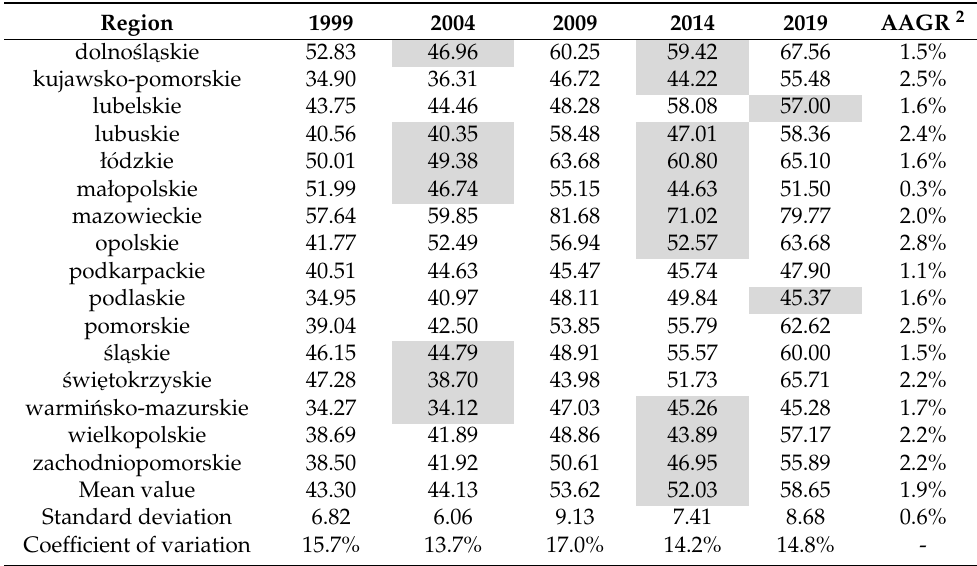
Table 2. Real 1 out-of-pocket monthly health expenditure per person